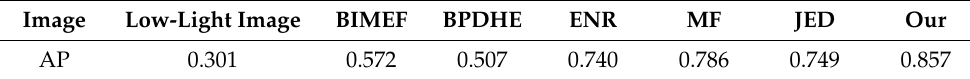
Table 4. The AP results of the images enhanced by different algorithms.